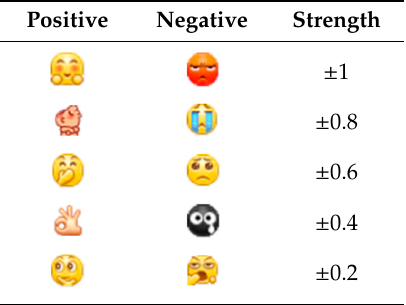
Table 2. Emoticon examples.